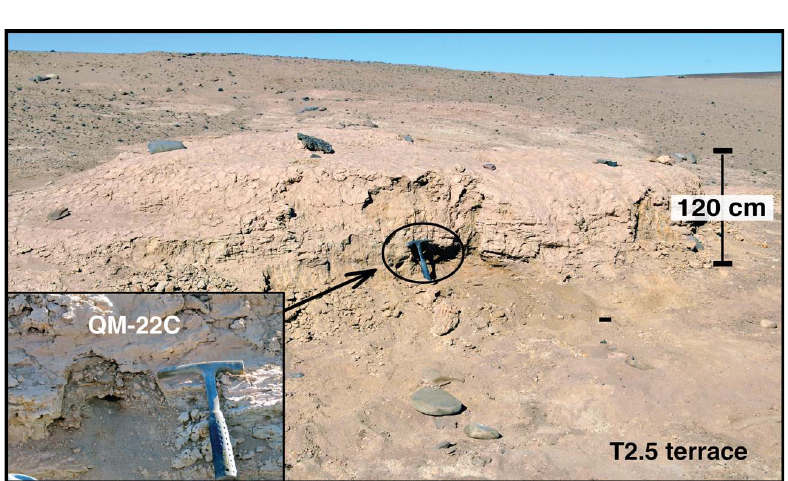
Fig. A3. Northern face of the remnant late Pleistocene paleowetland deposit containing rodent burrows. Arrow indicates where QM-22C rodent burrow was found.